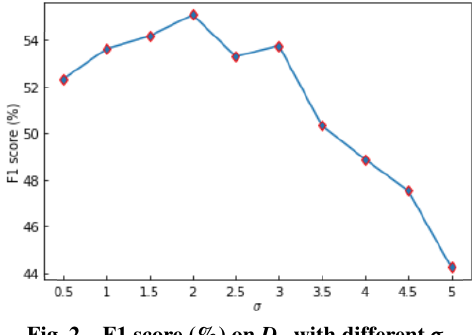
Fig. 2 F1 score (%) on D L with different (cid:27)(cid:27)(cid:27) .